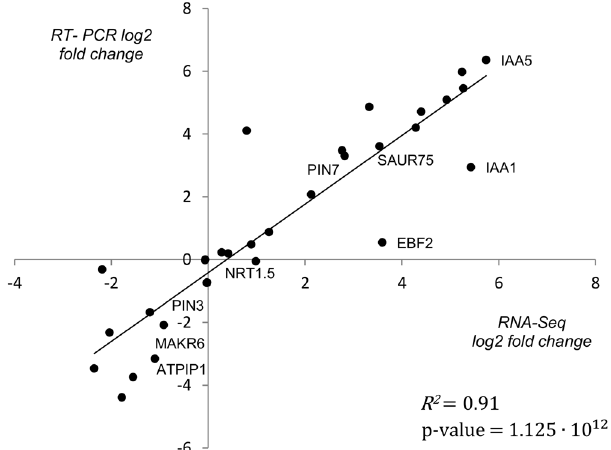
Figure 1. Scatterplot for log 2 fold changes of 30 genes in RNA-Seq and qPCR experiments. Both log 2 fold changes were well correlated ( R 2 = 0.91, p < 5.0E-12, Supplementary Table